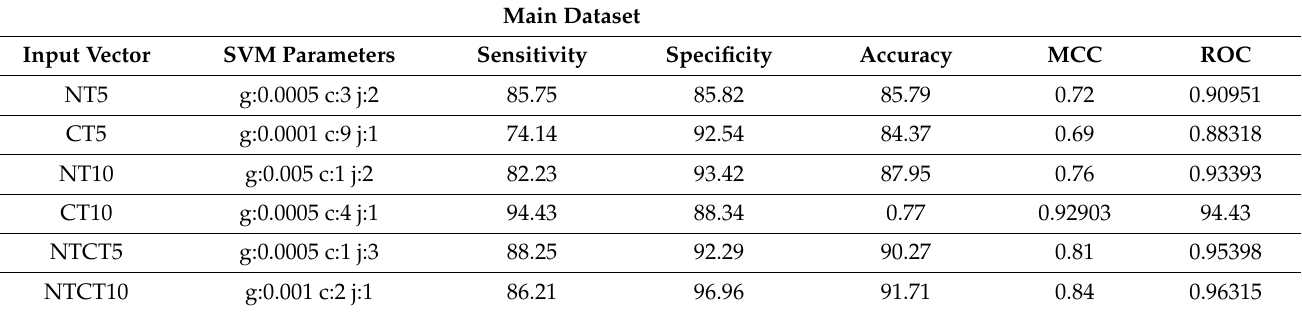
Table 2. Performance of SVM models developed using split acid composition using five-fold cross-validation. Main Dataset